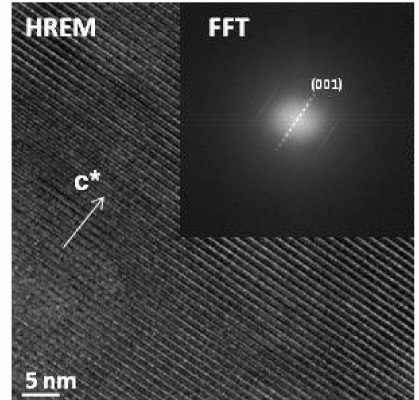
Figure 6. Energy filtered TEM lattice fringe image of phlogopite phase in multiphase inclusion 2 (diamond HI-105, #2802). Di ff raction pattern from Fast Fourier Transform